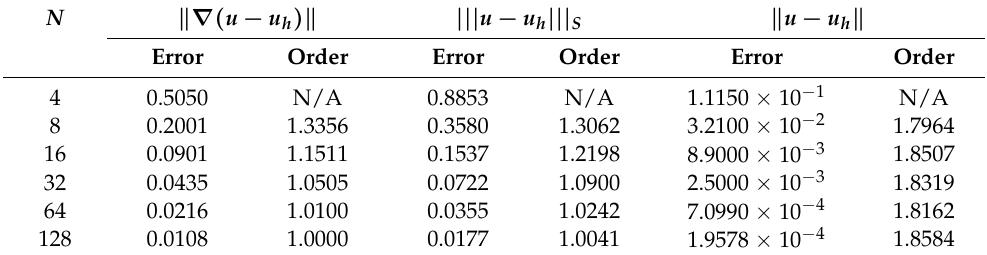
Table 6. Experiment results for the exact solution u = x 2 e y with B.C. V.